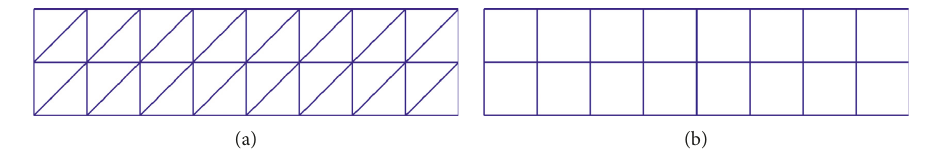
Figure 29: Domain discretization using triangular and quadrilateral elements.